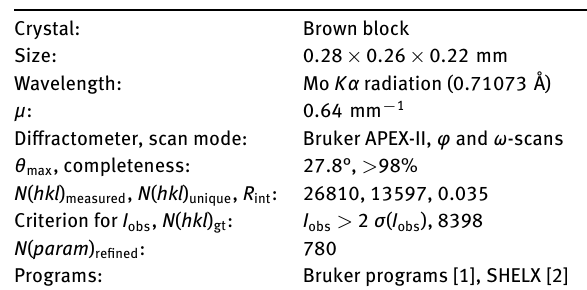
Table 1: Data collection and handling.